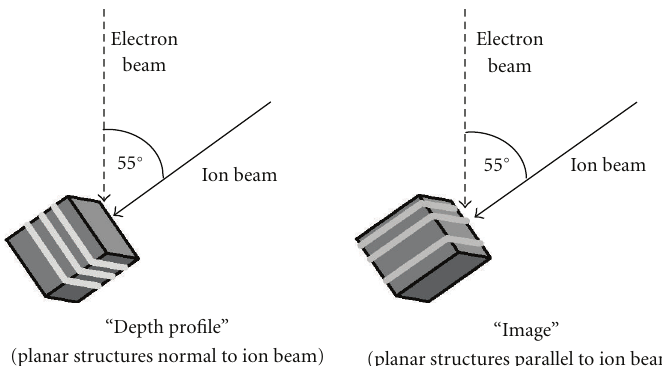
Figure 3: Clarification of the primary ion beam and sample orientation for the BAM L200, VCSEL, and ALD samples described in the text, all of which have planar structures. Depth profiles are reconstructed using the middle quarter of each image slice (“frame”) in order to minimise edge e ff ects. The resolution in the ion beam direction (depth resolution) is limited only by ion-induced mixing and roughening and redeposition/edge e ff ects and is in general better than the resolution in the directions normal to the ion beam (lateral resolution) which depends heavily on the spot size and shape.